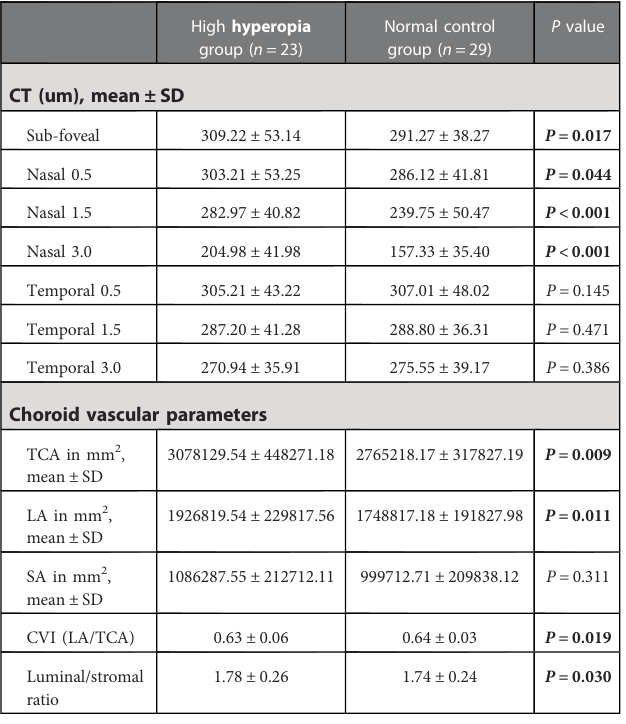
TABLE 2 Comparison of CT and choroidal vascular characteristics ( n =52).